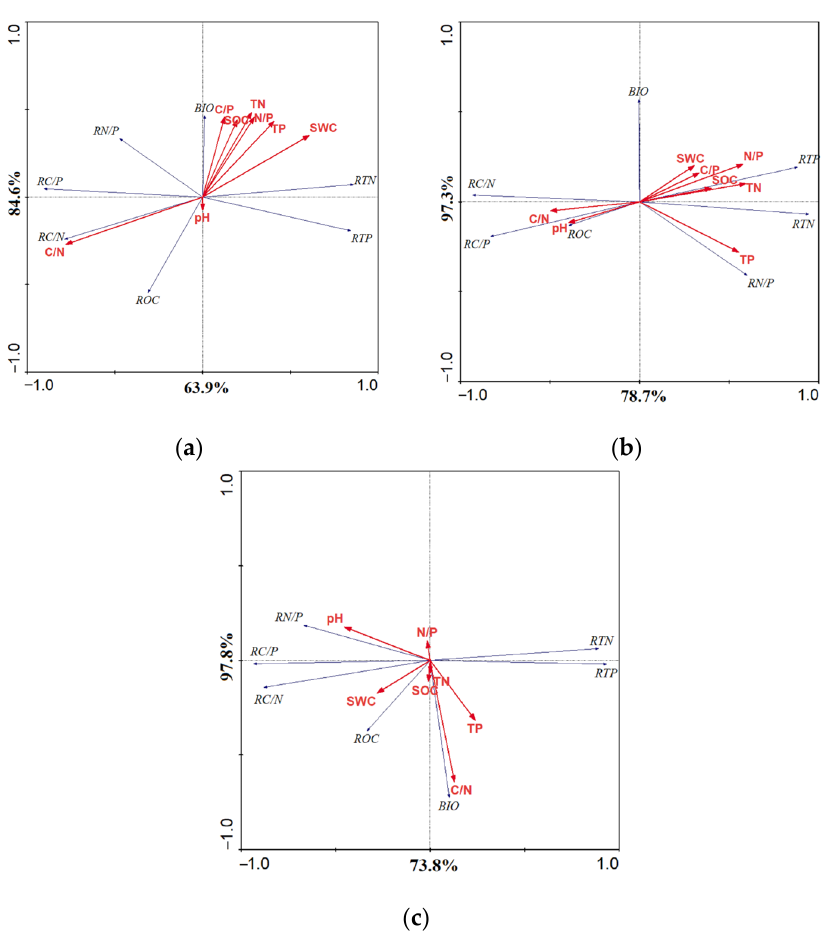
Figure 5. RDA of the fine-root–soil stoichiometry of Picea schrenkiana at different root sequences under the mixed organic–inorganic nitrogen source input levels in the Tianshan Mountains,